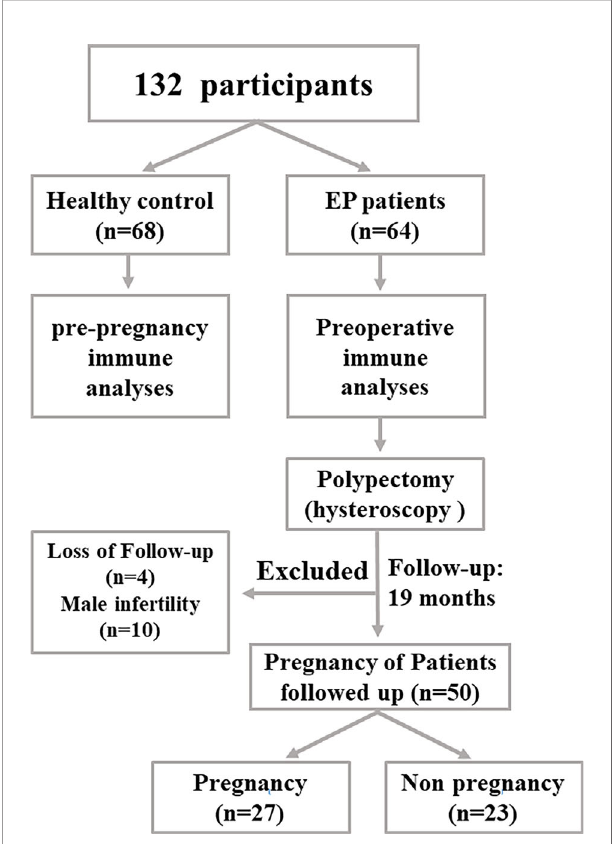
FIGURE 1 | The fl ow chart showing how this study was designed. In our work, 64 EP patients and 68 healthy population (control group) were enrolled to collect samples and perform subsequent